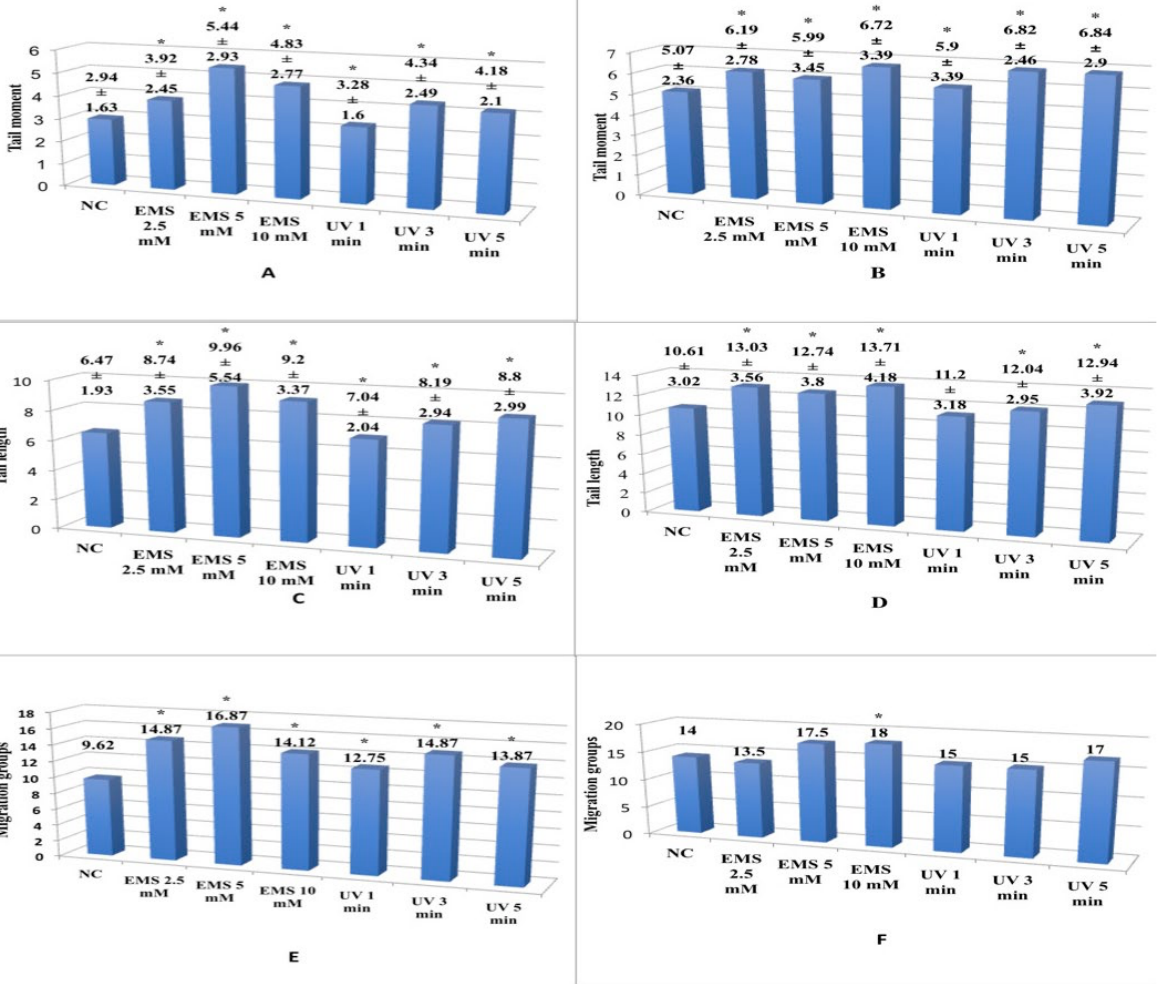
Figure 1. Induced genotoxic effect by different times or concentrations of UV-C and EMS evaluated with the parameters tail moment, tail length, and MGs in comet cells of Oreochromis niloticus ( A , C , E ) and Ambystoma mexicanum ( B , D , F ). * Significant differences ( p < 0.05) regarding the nega- tive control (NC).